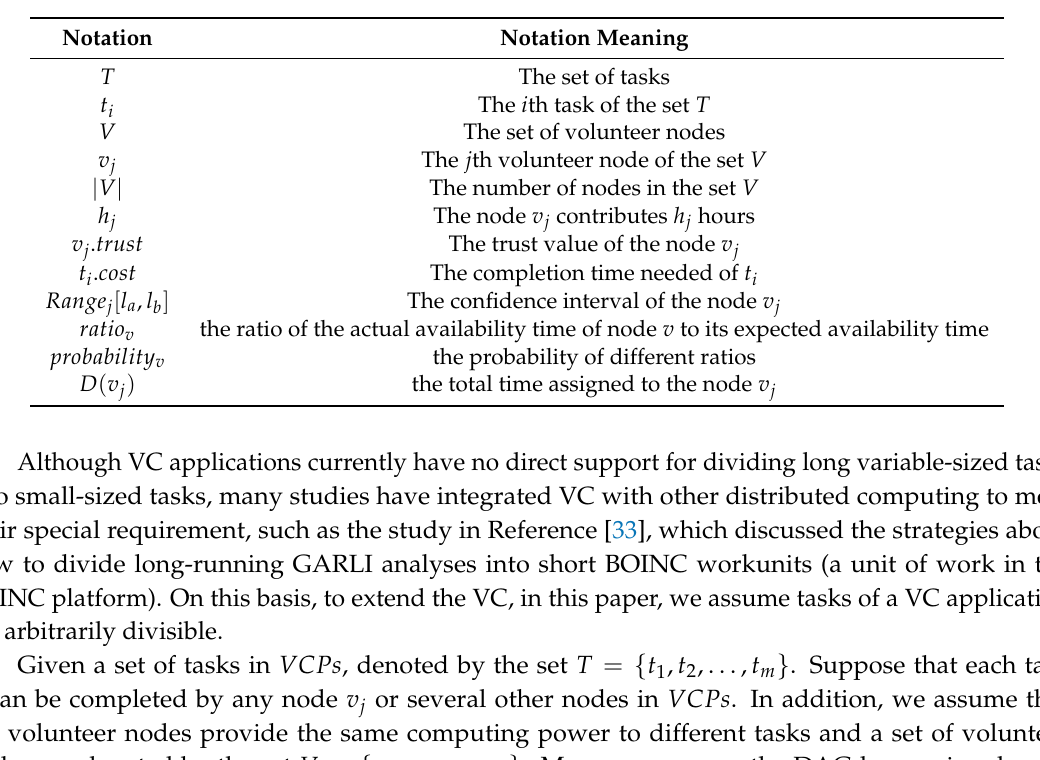
Table 1. Notations used in problem